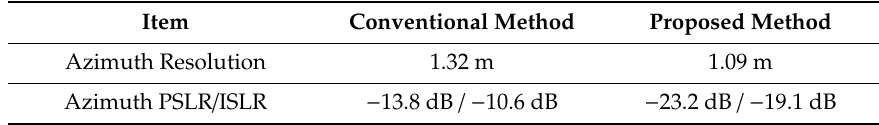
Table 3. Evaluation results of point targets simulation.